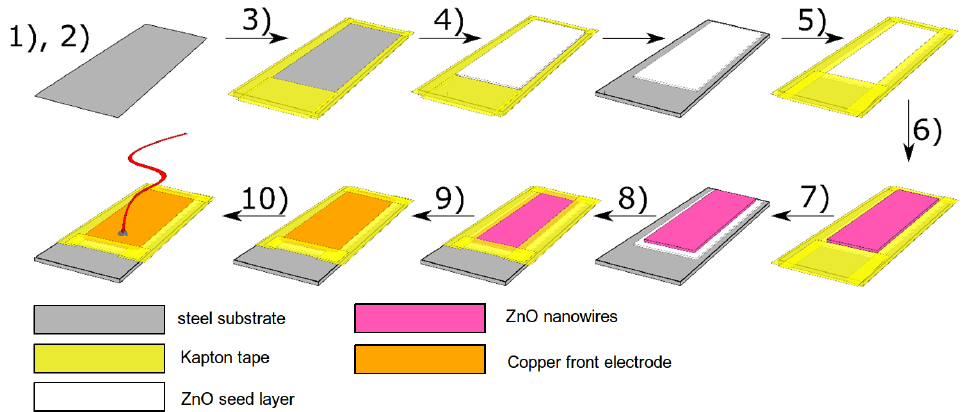
Figure 4. Manufacturing of the sample. ( 1 ) Cutting substrate (steel) into desired dimensions. ( 2 ) Degreasing and chemical cleaning of the substrate. ( 3 ) Masking of the substrate with Kapton tape prior to ALD deposition. ( 4 ) Deposition of adhesion layer and seeding layer via ALD on metal substrate. Materials employed were Al 2 O 3 and ZnO. ( 5 ) Masking of the substrate with Kapton tape prior to hydrothermal growth. ( 6 ) Hydrothermal growth of ZnO NWs via hydrothermal method on exposed seeded surface. ( 7 ) Cleaning from unwanted residues. ( 8 ) Masking of the sample with Kapton tape before mounting of top electrode. ( 9 ) Placing and immobilization of top copper electrode to achieve contact only with Kapton tape and surface of ZnO nanowires. ( 10 ) Wiring of the top